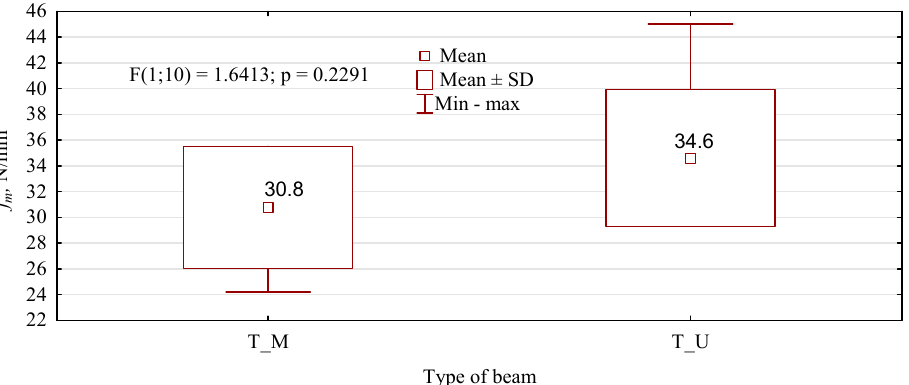
Figure 15. Static bending strength of beams with a modified outer layer.